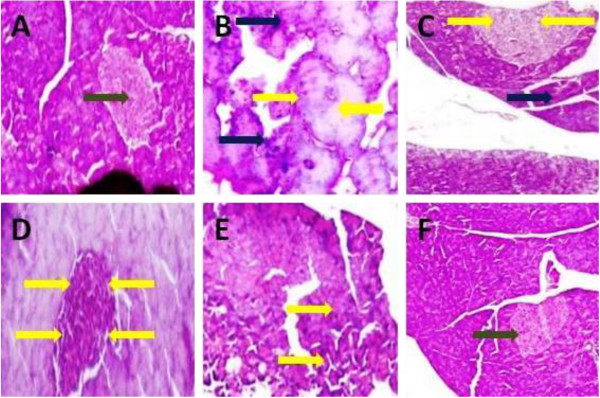
Photomicrographs of histological changes of rat pancreas of isletes of Langerhans: (A) Normal control: normal histological structure of rat pancreas showing normal islet (green arrow) (B) Diabetic control: diabetic control rat showing dilated acini (blue arrow) and focal necrosis (yellow arrow) (C) MM I (100 mg/kg): tested drug rat showing dilated acini (blue arrow) and focal necrosis (yellow arrow) (D) MM II (250 mg/kg): tested drug rat showing and focal necrosis (yellow arrow) (E) MM III (500 mg/kg): tested drug rat showing and focal necrosis (yellow arrow) (F) Glibenclamide (10 mg/kg): glibenclamide treated rat pancreas showing normal islet (green arrow). For each group 6 rats were examined and 50 pictures were taken. The above picture for each group was chosen randomly from the 80 pictures in this group. Original magnification, 10 ×.